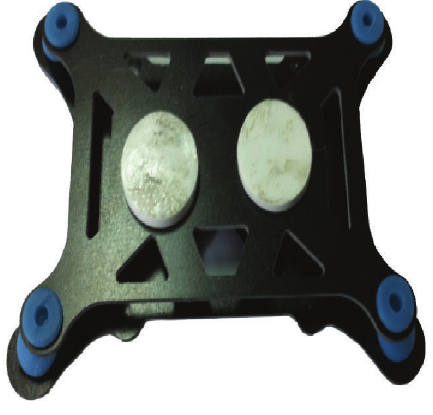
Figure 7: Shock absorber.